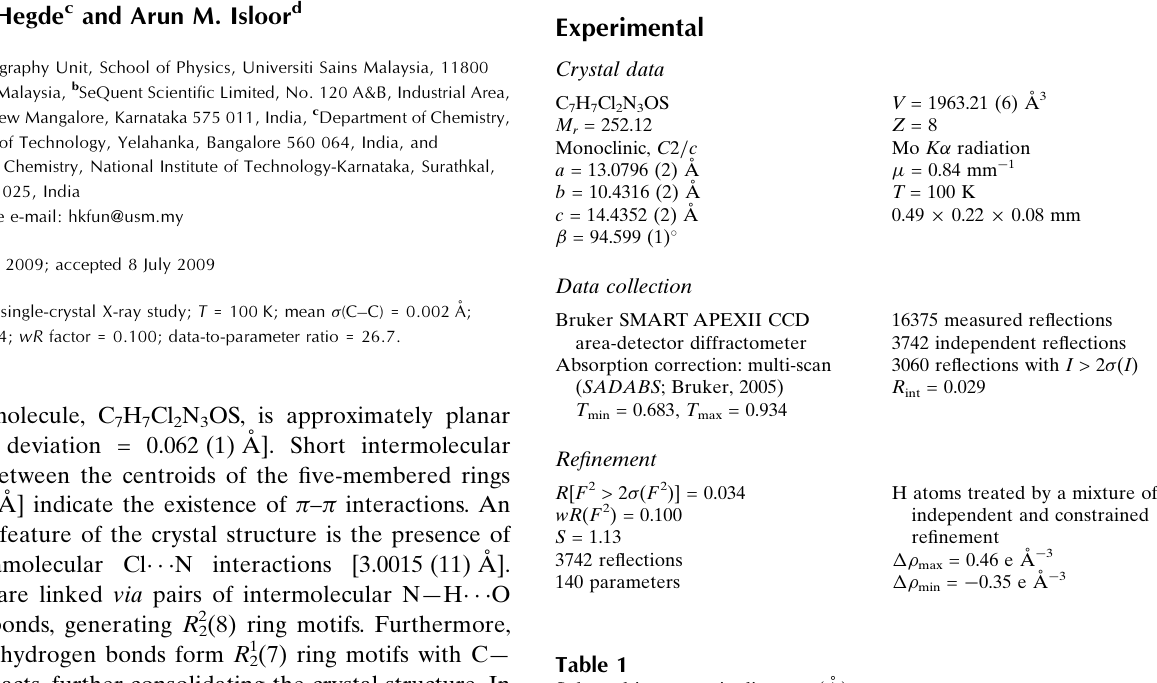
Selected interatomic distance (A˚ ).